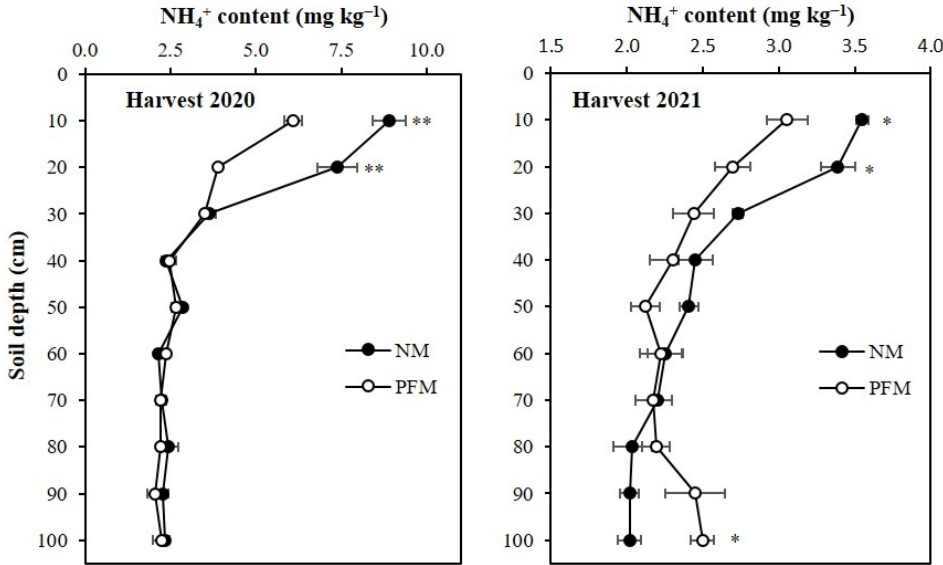
Figure 6. Effects of plastic film mulching and no-mulching treatments on the depth distribution of NH 4+ in the soil profile at final harvest of maize. ** Significant differences between treatments at p < 0.01, * significant differences between treatments at p < 0.05. Harvest 2020, soil sampling at final harvest in 2020; Harvest 2021, soil sampling at final harvest in 2021 PFM, plastic film mulching; NM, no-mulching